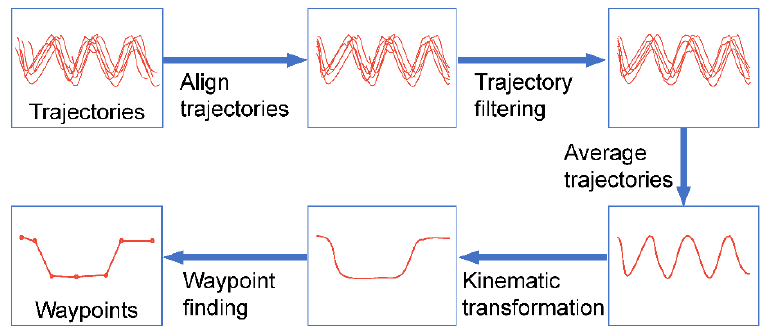
Figure 5. Diagram of skilled operator ’ s excavation trajectory analysis and waypoint finding progress.